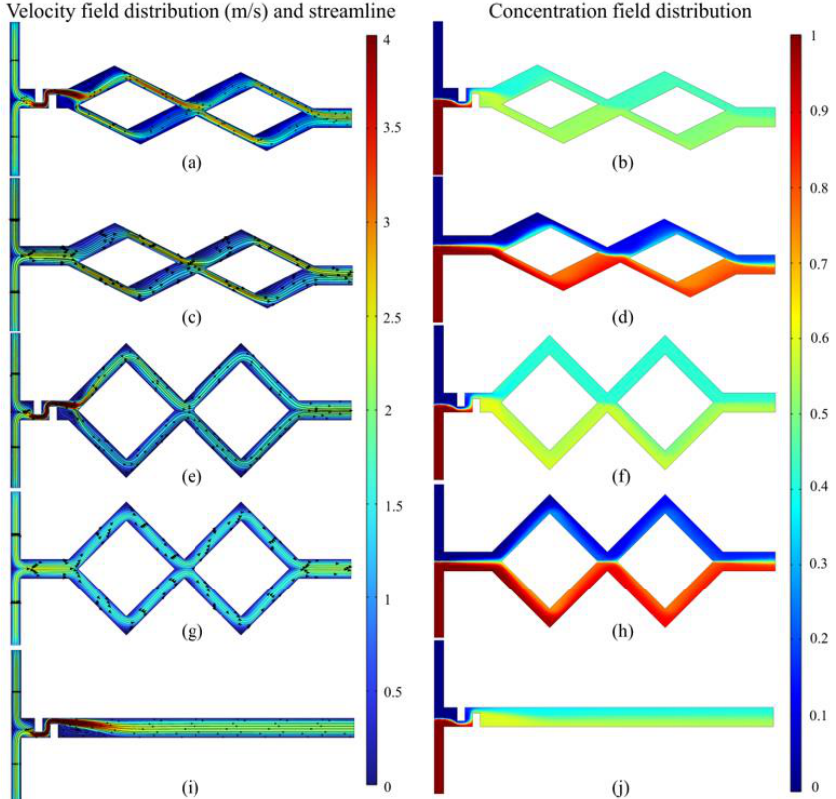
Figure 8. Velocity field distribution (m/s) and concentration field distribution of five micromixers at Re = 60. ( a , b ) Asymmetric rhombus micromixer with baffles; ( c , d ) Asymmetric rhombus micro- mixer without baffles; ( e , f ) Symmetric rhombus micromixer with baffles; ( g , h ) Symmetric rhombus micromixer without baffles; ( i , j ) Micromixer only with baffles.